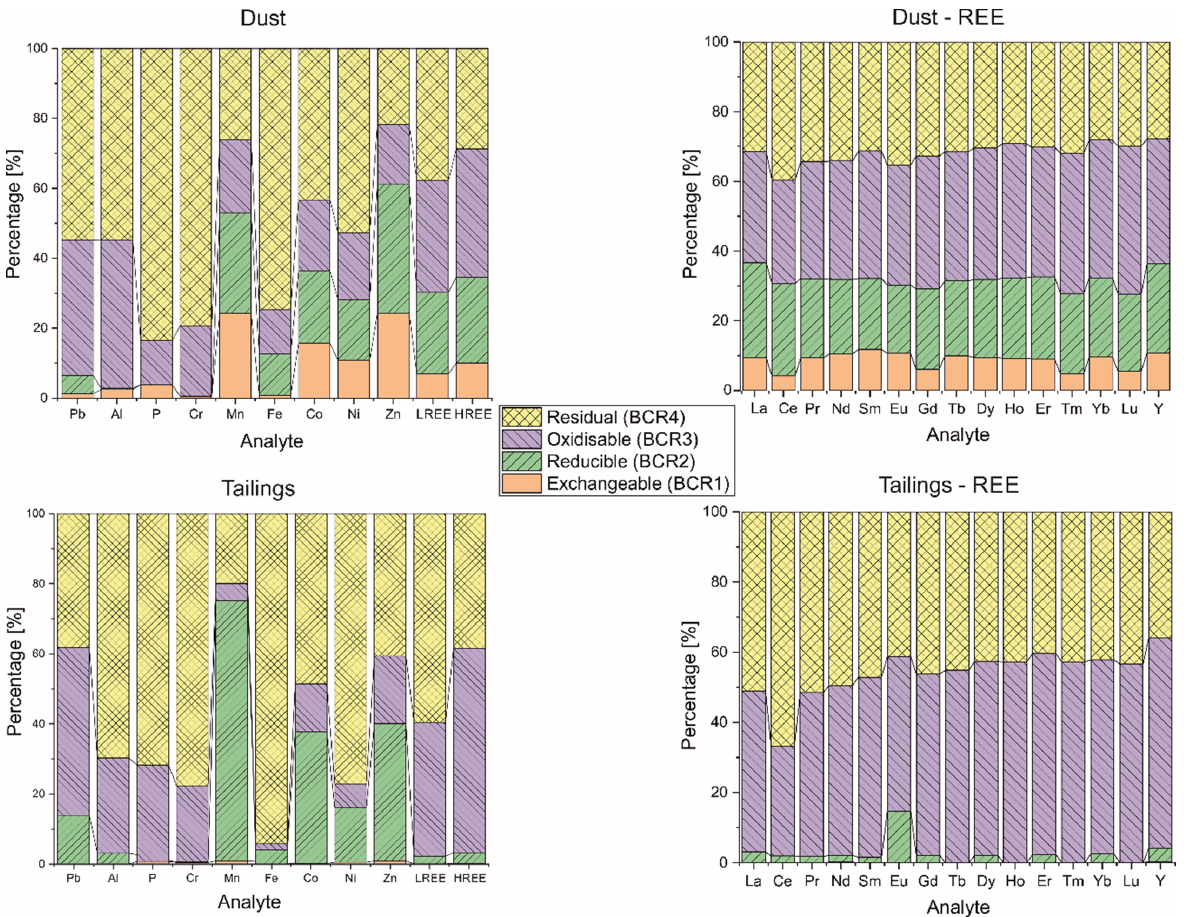
Figure 7. Weight fraction of analysed elements in dust and tailings obtained by BCR sequential analysis. Y is added to HREE due to its chemical and physical affiliations as stated in [36].